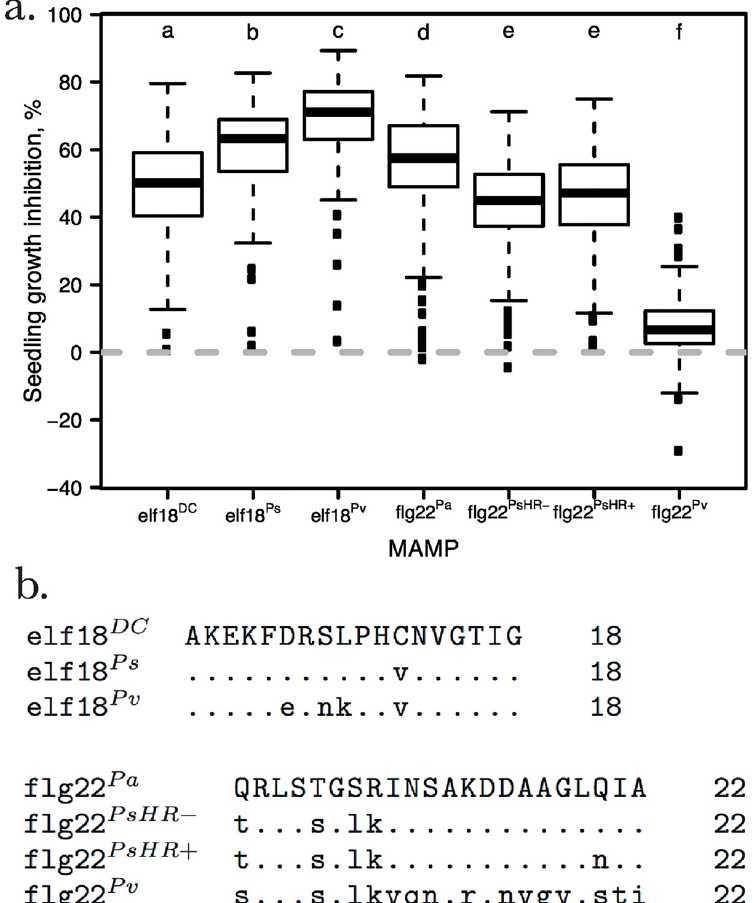
Fig 1. MAMP recognition varies quantitatively between MAMP alleles and between A. thaliana genotypes. (a) Three elf18-variants and four flg22 variants were used to trigger SGI in 186 genotypes of A. thaliana . The x-axis indicates the MAMP variant and bacteria of origin: Pseudomonas syringae pv. tomato DC3000 (DC), P. syringae (PsHR-, PsHR+), P. viridiflava (Pv), and P. aeruginosa (Pa). Plotted are mean SGI values of 186 genotypes. The mean SGI for each A. thaliana genotype is estimated by calculating the relative reduction of fresh mass in percent. At least three replicates were measured per genotype and treatment to calculate mean SGI. The horizontal bar of the boxplot represents the median, the edges of the box present the 25th and 75th percentile. The whiskers are drawn at the data point that is closest to 1.5 x interquartile range. All outliers are shown. Small letters above the boxes indicate statistically different groups (ANOVA/ Tukey ’ s post hoc test). (b) The peptide sequences of both elf18 and flg22 differ between closely related Pseudomonads ( P. syringae and P. viridiflava ) and within P. syringae